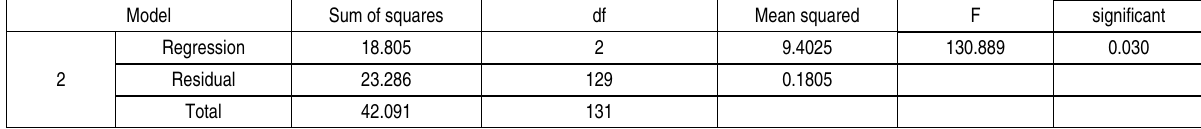
Table 12. ANOVA outcomes for acceptance of gender